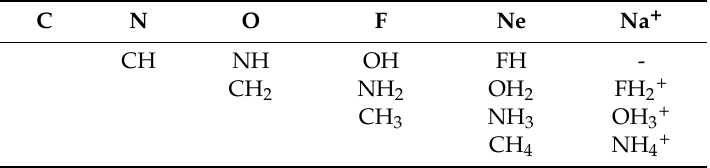
Table 1. Grimm’s Hydride Displacement Law.